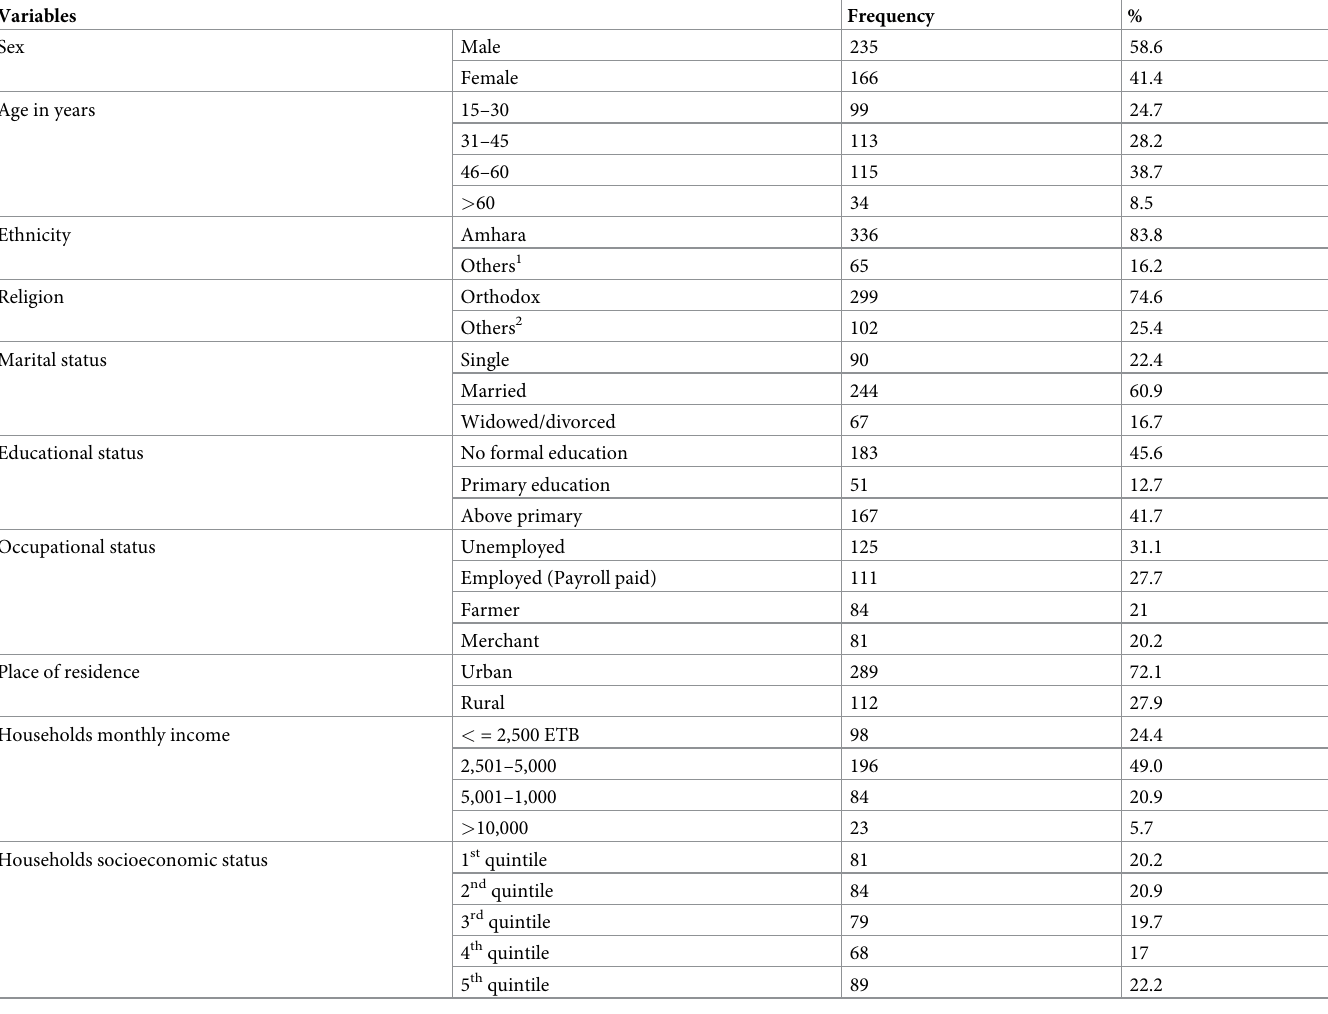
Table 1. Socio-demographic and socio-economic characteristics of diabetic patients in Bahir Dar city administration public hospitals, Ethiopia,